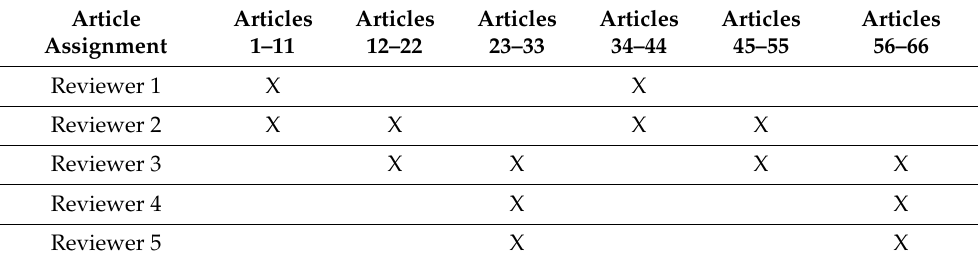
Figure 1. Preferred reporting items for systematic reviews and meta-analysis (PRISMA) figure that demonstrates the PRISMA-guided study selection process. Table 1. Reviewer assignment of the initial database search findings (full article review).